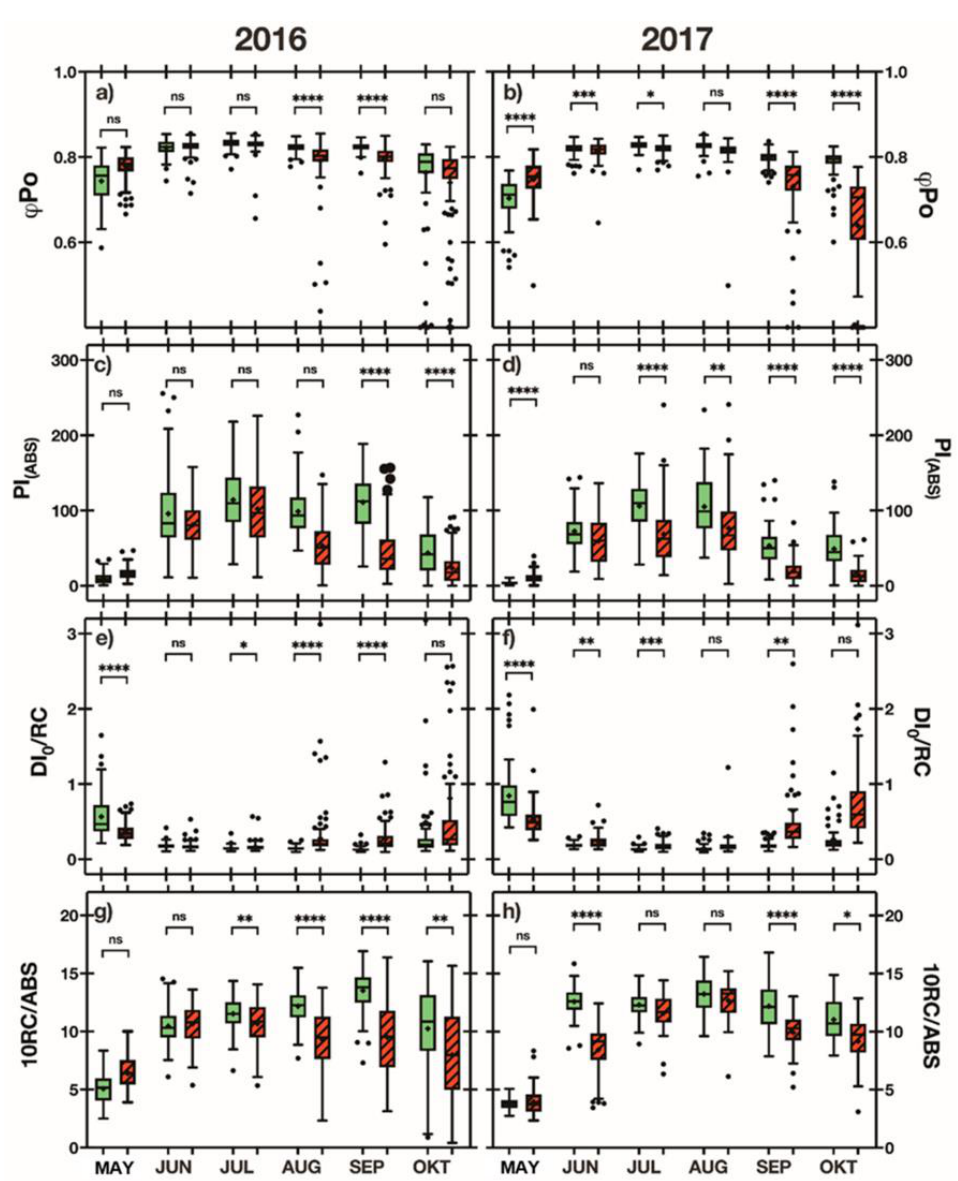
Figure 2. Comparison of photosynthetic performance and stress parameters. OPM-infested leaves of oaks (red colour) and of non-infested leaves (green colour) in the urban area of Rathenow, Bran- denburg. May to October 2016 and 2017. ( a , b ) Po = PHI Po = Fv/Fm = quantum efficiency of PS II, indicator of general leaf condition. ( c , d ) PIABS = Performance Index, indicator for the efficiency of the photosynthetic light reaction up to the start of PS I. ( e , f ) DIo/RC = Energy loss of the photosynthetic reaction center, targeted heat release as protection against over-energetisation of the photosystem, protection against cell damage. ( g , h ) 10RC/ABS = Degree of opening of the reaction centres in PS II, which indicates how well light energy can be absorbed for photosynthesis. Displayed in boxplots with Tukey interval. Cross-lines in boxes, median. Crosses, mean values. Significances calculated by analysis of variance (one-way ANOVA). Significance level: ns = p > 0.05; * = p < 0.05; ** = p < 0.01; *** = p < 0.001; **** = p < 0.0001.